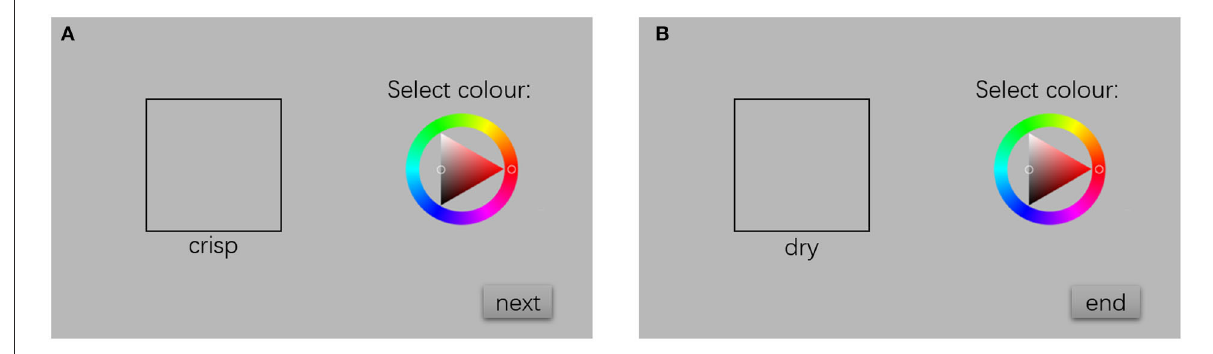
FIGURE1 The colour selection interface for (A) crisp and (B) dry.